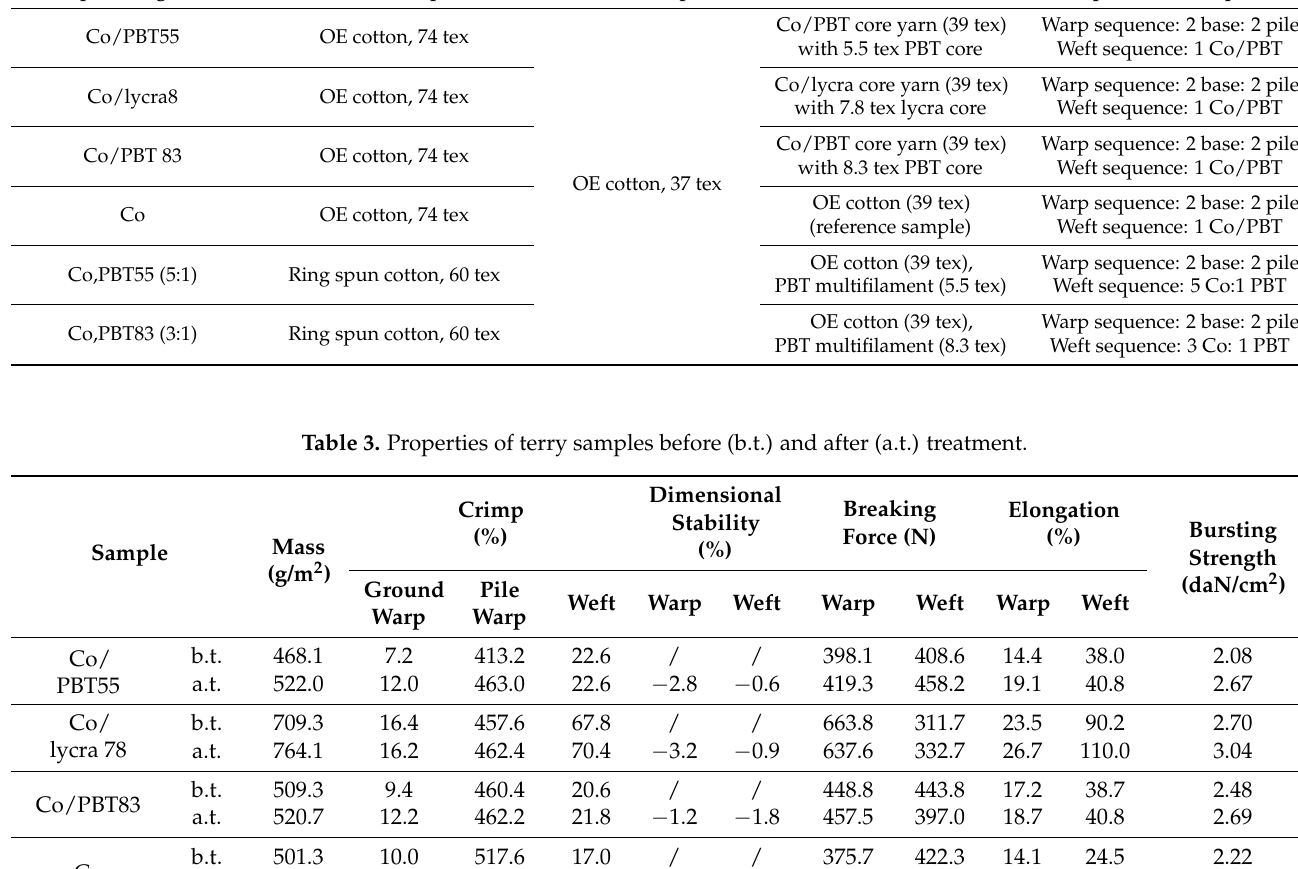
Table 2. Basic constructional parameters of face-side three-pick terry (base weave: mixed rip 2/3). Sample Designation